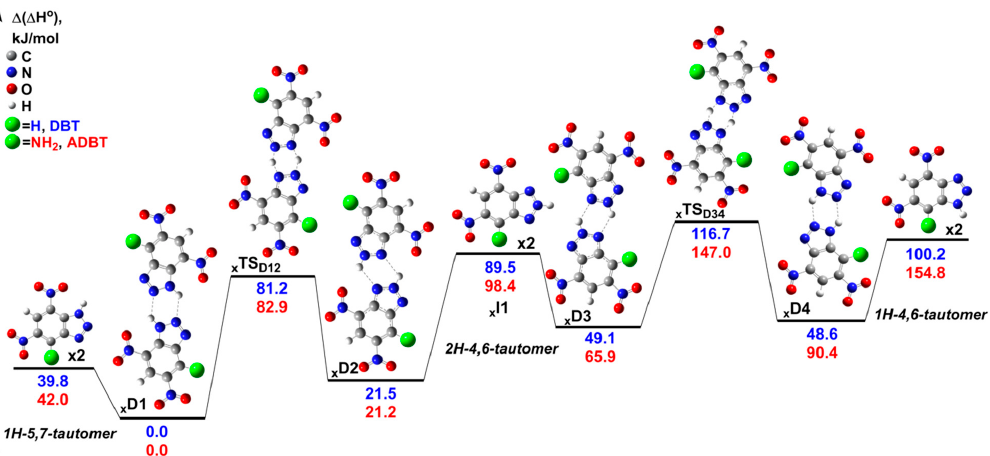
Figure 8. The relevant stationary points on the PES corresponding to the tautomeric interconversions of DBT and ADBT in dimers. The 1H-5,7-tautomers of DBT and ADBT are chosen as the reference compounds for the calculation of the relative enthalpies at 298 K ( ∆ ( ∆ H ◦ )). The geometry optimization and calculation of the thermal corrections were performed at the M06-2X/6-311++G(2df,p) level of theory, and the single point energies were computed at the DLPNO-CCSD(T)/jun-VQZ level. All energy values are given in kJ mol − 1 .